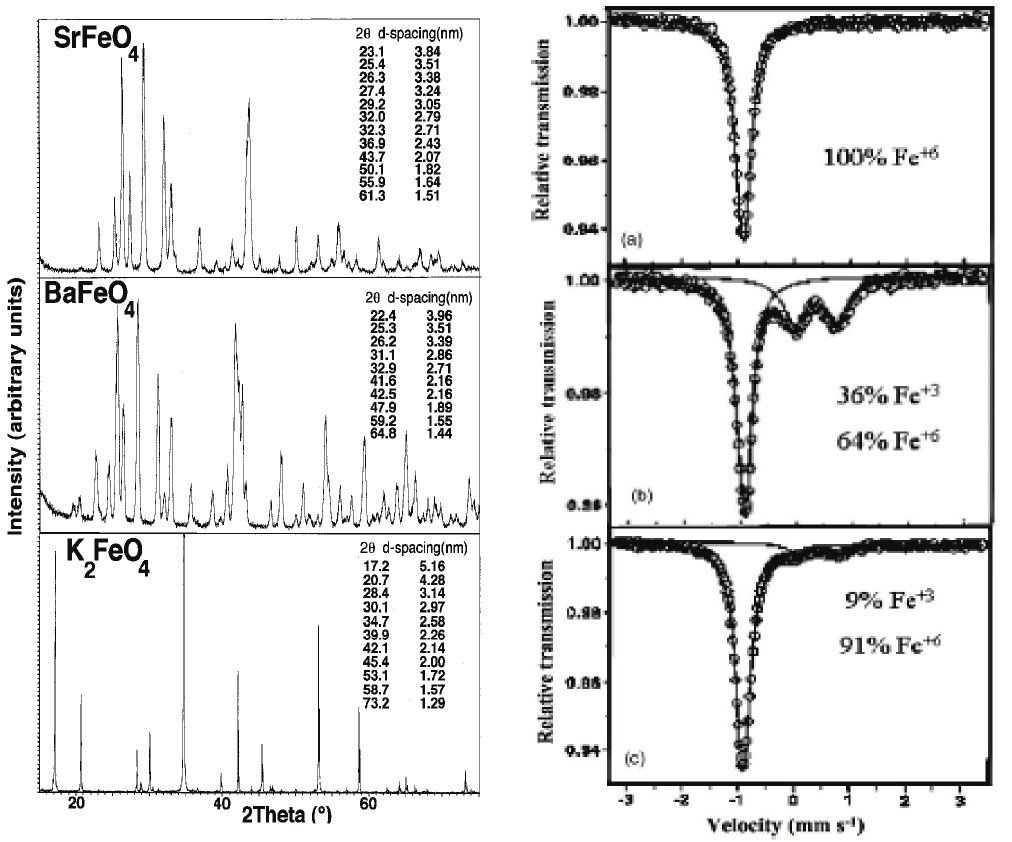
Figure 6. Left: X-ray analysis of Fe(VI) compounds, evidence of their orthorhombic β -K SO analogue structure, from "Recent advances in the synthesis and analysis of Fe(VI) 2 4 cathodes." Licht, et al. , J. Solid State Electrochem. 2008 , 12 , 1523. Right: Mössbauer spectra of K FeO : (a) pristine electrode, (b) polarized to 1.5V vs. Li/Li + , and (c) after one 2 4 complete lithiation cycle. From "Study of Various ("super iron") MeFeO salt solutions as cathode materials for Li batteries." J. Electrochem Soc. 2006 , 153 ,